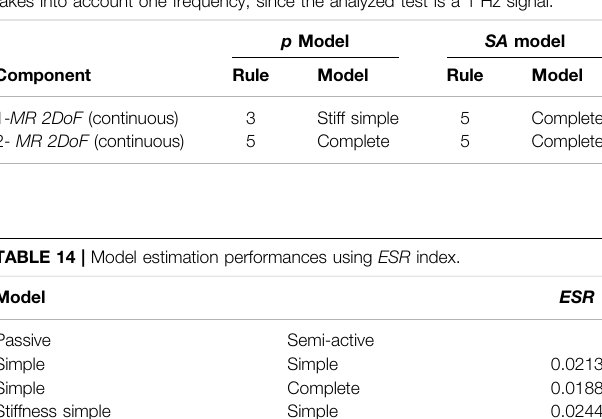
TABLE 13| Classi fi cation ofcharacteristicdiagramsandproposedmodels. Itonly takes into account one frequency, since the analyzed test is a 1 Hz signal.